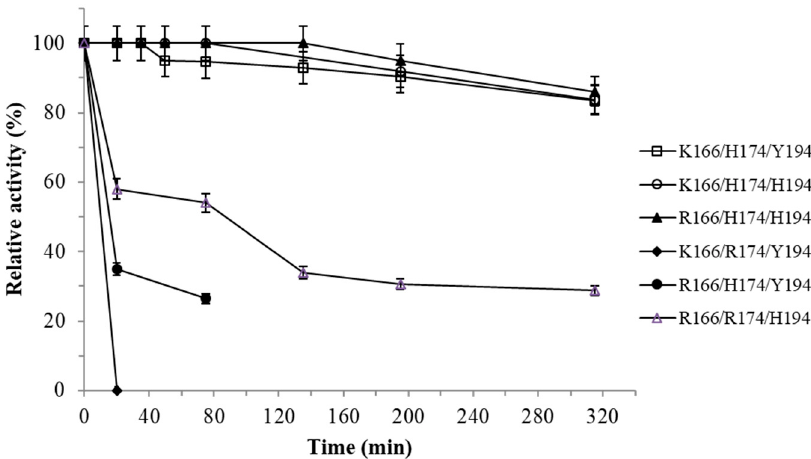
Figure 2. Stability of the soluble Tt27-NOX variants at 80 °C and pH 7. The experiments were carried out in 10 mM sodium phosphate pH 7 under FMN-saturating conditions. Enzymatic activity determined in 10 mM sodium phosphate pH 7, 37 °C, 150 µM FMN, and 0.25 mM NADH.